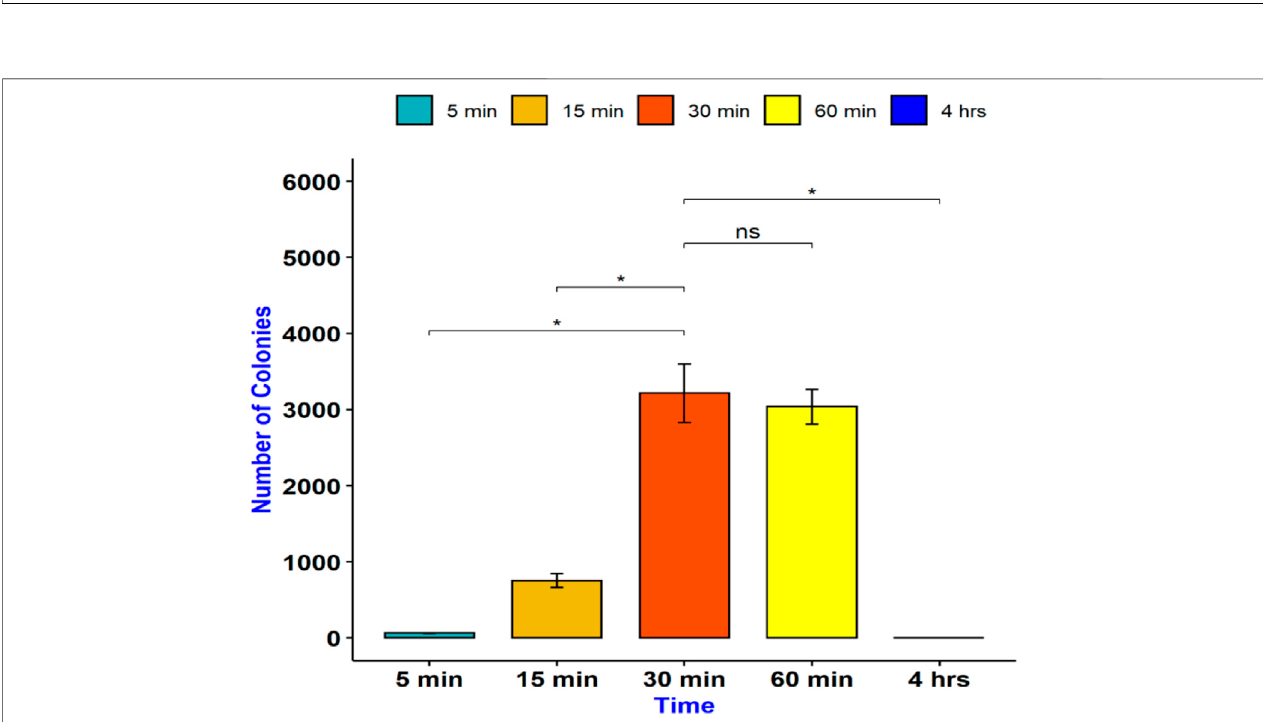
FIGURE 3 | Gene delivery by COOH-FCDs at different time intervals. Maximum plasmid size that can be delivered into E. coli using COOH-CDs.